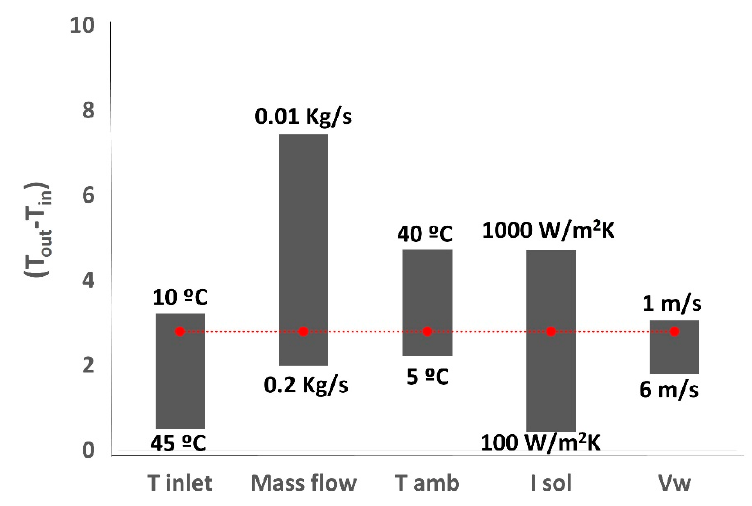
Figure 15. Summary of the parametric study representing the maximum and minimum achievable thermal difference ( T out − T in ).